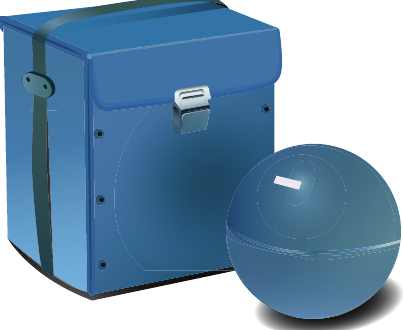
Figure 1: Rubber ball for heavyweight impact test.